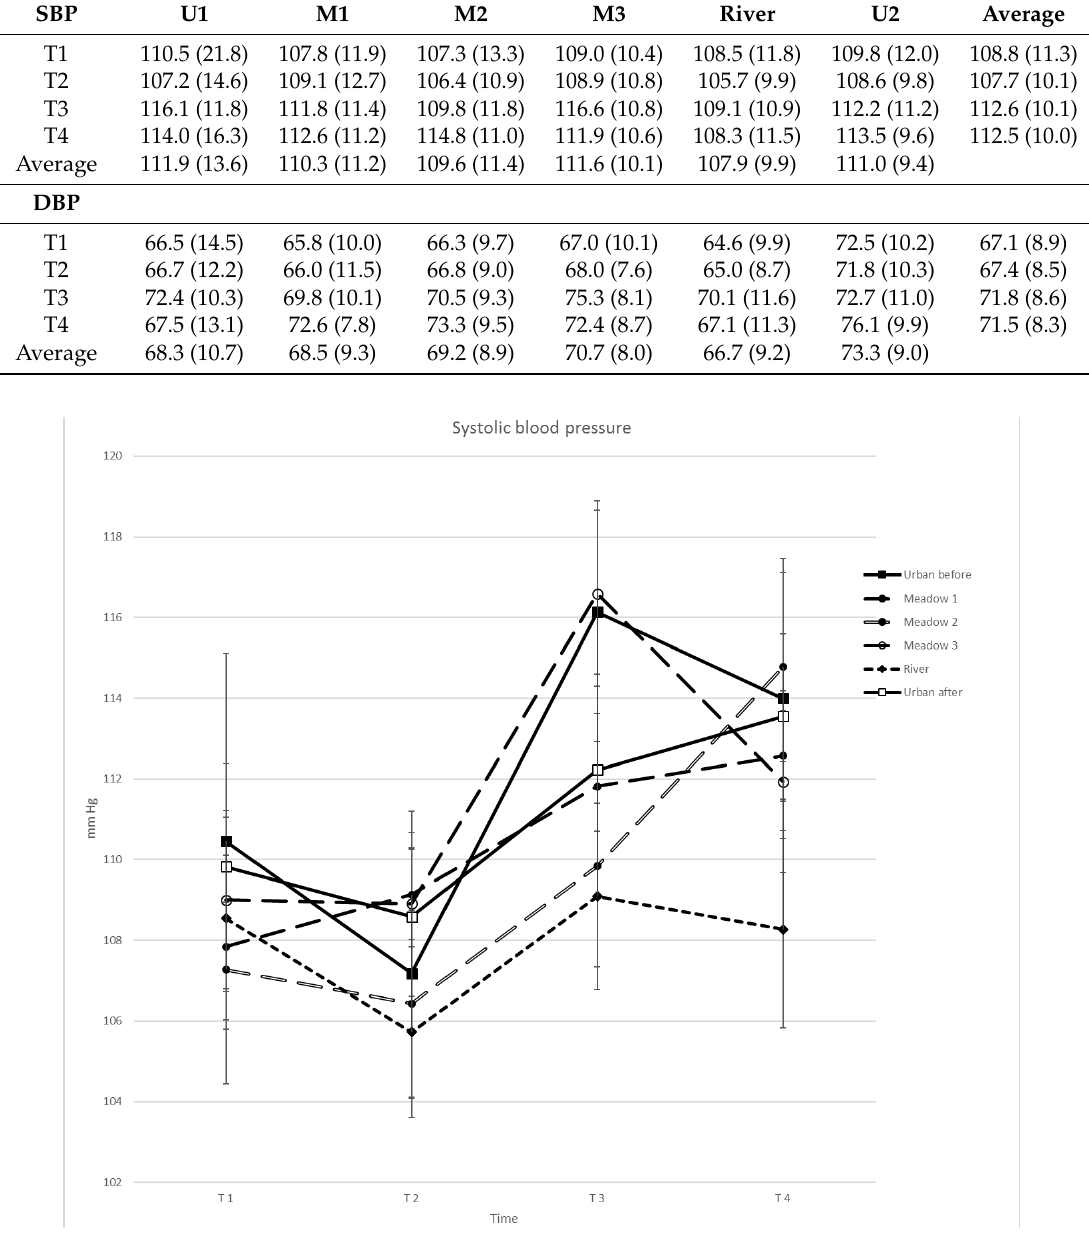
Figure 4. Mean systolic blood pressure per site and time ( N = 22).